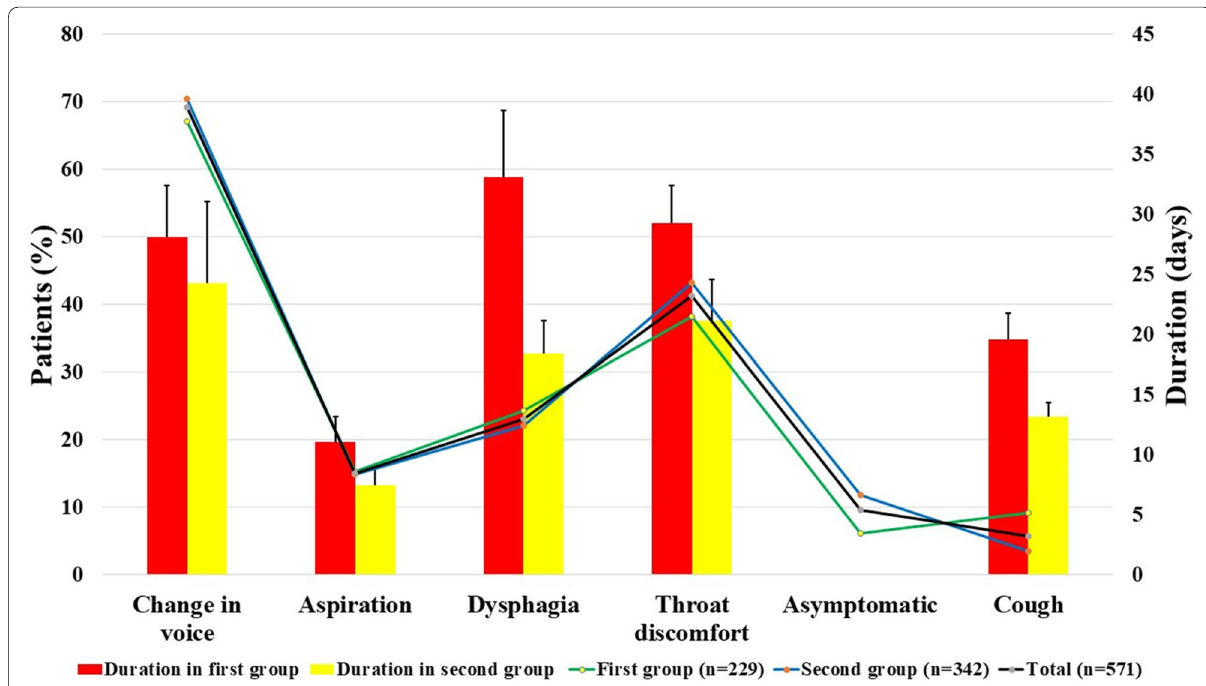
Fig. 1 Presenting features and duration of onset (with their SD) in UVCP